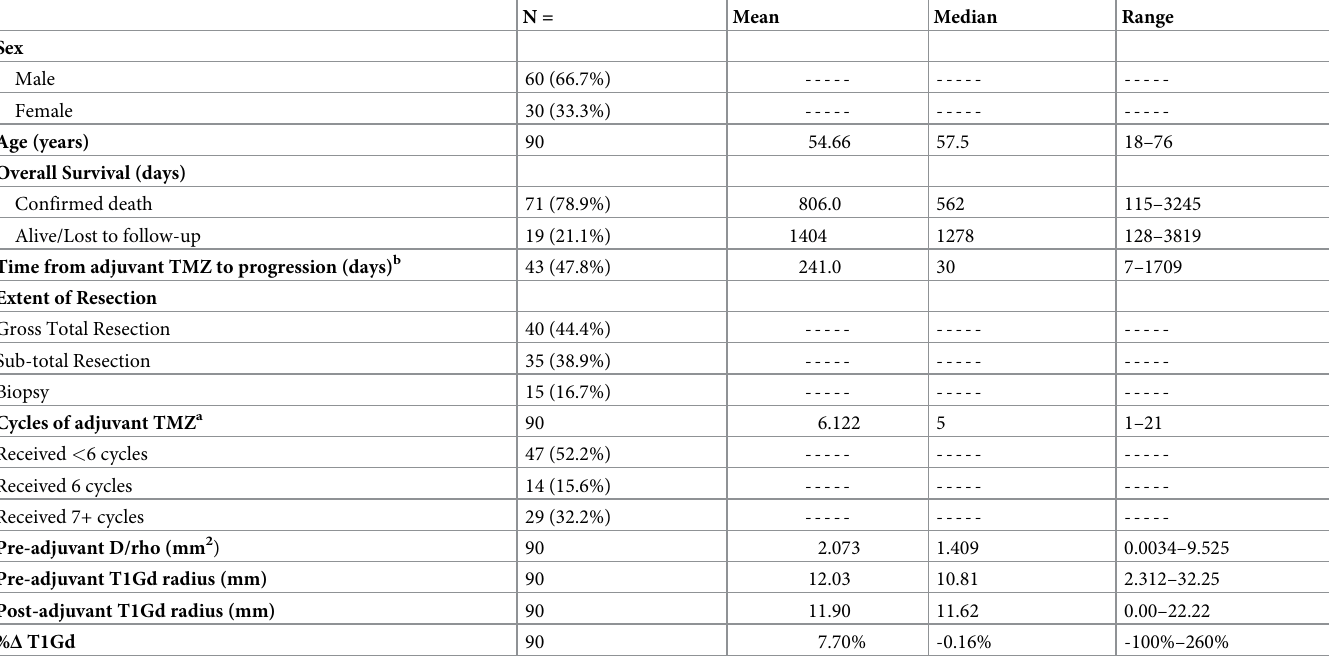
Table 1. Distributions and counts of relevant demographic, volumetric, and treatment-based patient